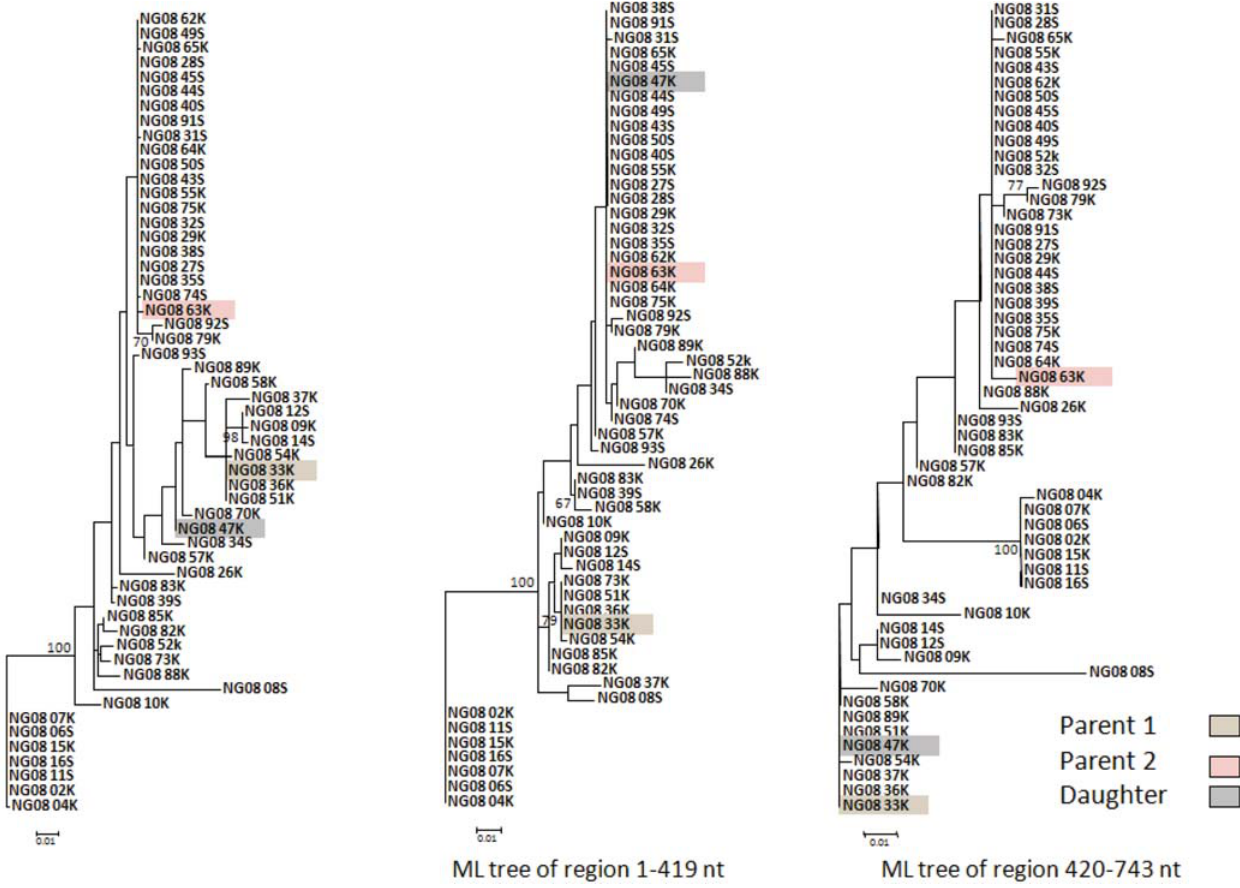
Figure 9. Example of recombination detection in the NS5a region (NG08T0 sample). The phylogenetic tree on the left corresponds to the analysis of the complete region whereas the other two are derived from the two regions defined by the detected recombination event.